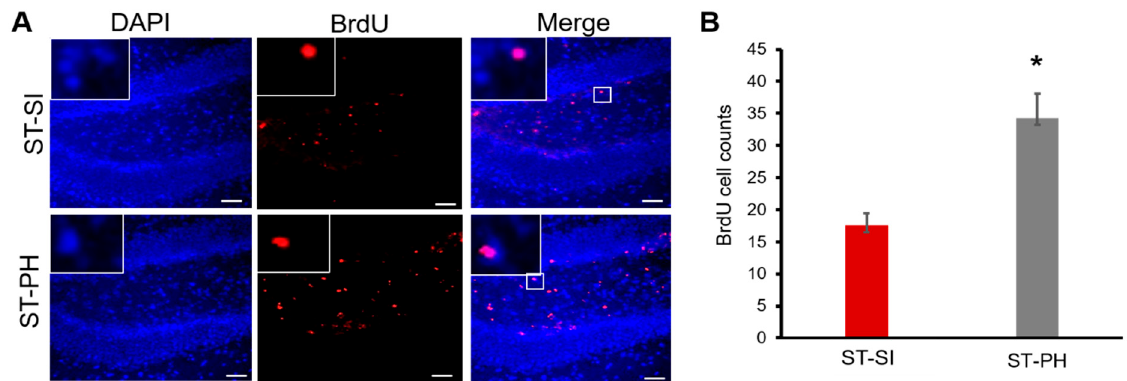
Figure 4. PH aged females had higher cell proliferation compared to SI animals after stroke. ( A ) Representative images of the hippocampus of brain sections from mice administered bromodeoxyuridine (BrdU) (day 3 to 7) after stroke. Immuno- histochemistry analysis and co-labeling with anti-BrdU (in Red) and DAPI (in blue) showed that mice that were isolated immediately after a stroke had lower BrdU-positive cells in the dentate gyrus. Magnified images in insert show co-labeling of BrdU and DAPI. Scale bar denotes 75 µm ( B ) Quantification of these BrdU-positive cells showed a significant increase in cell proliferation in the dentate gyrus of ST-PH mice compared to the ST-SI mice ( n = 4/group. * p = 0.008). Data are presented as mean ± SEM. Student’s t-test was used for group comparisons.